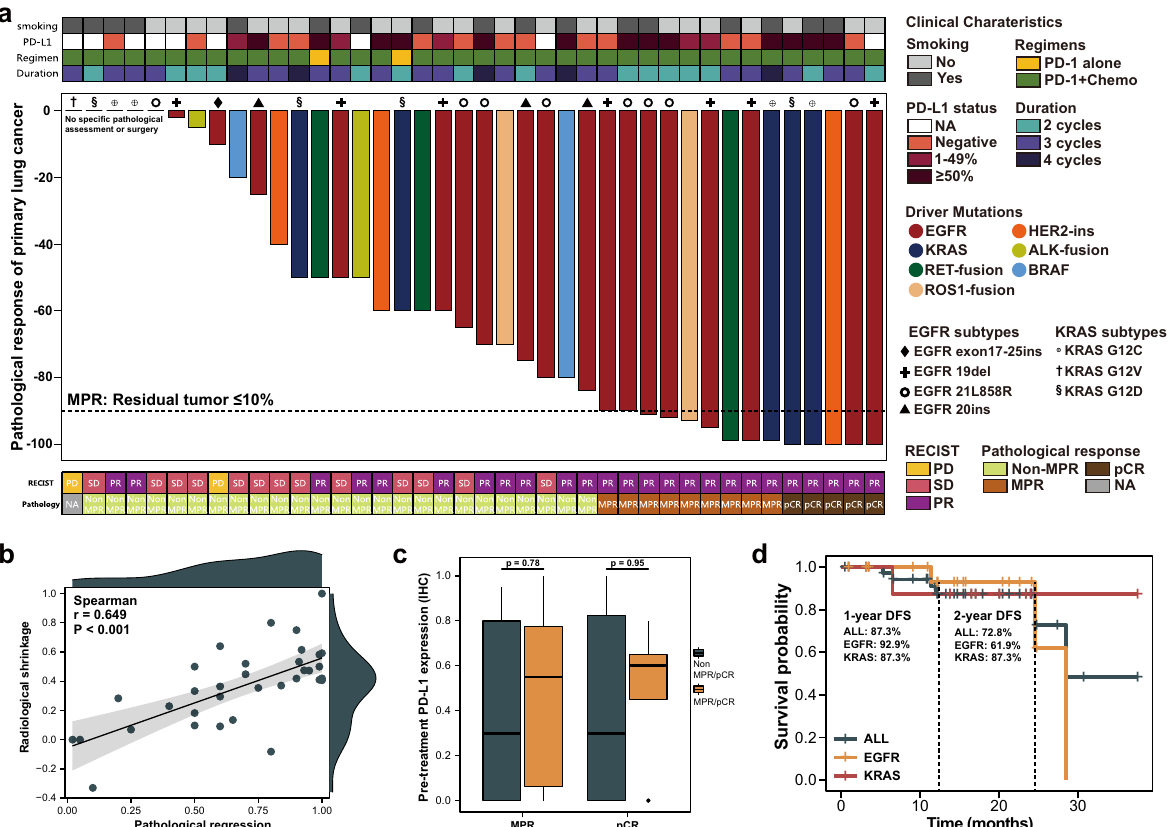
Fig. 1 Overview of clinicopathological characteristics and clinical outcome of oncogene-mutant NSCLC treated with neoadjuvant immunotherapy. a Overview of clinicopathological charteristics and clinical outcome of oncogene-mutant NSCLC treated with neoadjuvant immunotherapy. Clinicopathological charateristics including smoking status, therpeutic regimens, PD-L1 expression, treatment duration and preoperative radiologic response (according to Response Evaluation Criteria in Solid Tumors [RECIST]) were annotated for each patients. The horizontal dash line indicates the threshold for a major pathological response (90% regression). Pathological regression was presented in colored bar plot regarding different oncogene mutation. b Correlation between radiological shrinkage and pathological regression. Spearman correlation was used to measure the relevance. c Association between PD-L1 expression and MPR status. Centre line represents the median value of PD-L1 expression. Error bars represent the upper and lower quartiles of PD-L1 expression and whiskers de fi nes the minimal and maximun value. PD Progression disease, SD Stable disease, PR Partial response, MPR Major pathological response, pCR Pathological complete response. d Disease-free survival (DFS) of all patients, EGFR-mutant patients and KRAS-mutant patients treated with neoadjuvant immunotherapy through Kaplan-Meier survival integrated the individual data of EGFR-mutant cohort from CTONG1103 (NCT01407822) study to compare the ef fi cacy of different neoadjuvant treatment modalities. Patients were strati- fi ed into 3 groups for subsequent analysis: chemotherapy (GC regimen), targeted therapy (erlotinib) and immunotherapy plus